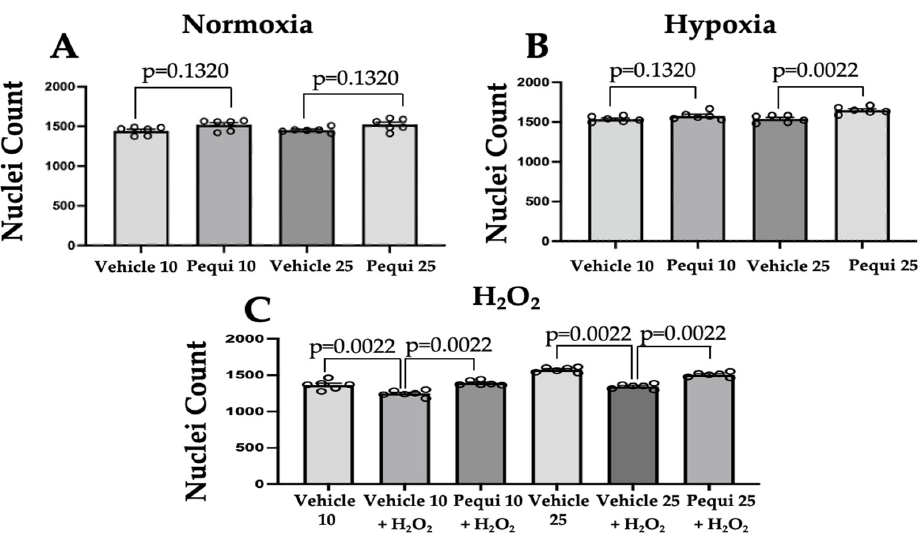
Figure 5. Human coronary artery endothelial cell proliferation assay. HCAEC were pre-treated for 24 h with 0 (Control), 10, or 25 µ g/mL of Pequi extract. Cells (1 × 10 4 cells/well) were subjected to normoxia ( A ) or hypoxia ( B ) for 48 h or 100 μ M H 2 O 2 for six hours ( C ). Cell proliferation significantly increased in hypoxia (25 μ g/mL group) as compared to vehicle-only (DMSO) control. Although proliferation decreased after addition of H 2 O 2 in HCAEC without extract, an increase in proliferation was observed when cells were pre-treated with pequi extract. Variance analysis revealed differences between the treatments ( C ). Experiments were carried out using six ( n = 6) independent experiments, each consisting of 5 replicates per condition/group. Statistical analysis was carried out using Mann– Whitney’s